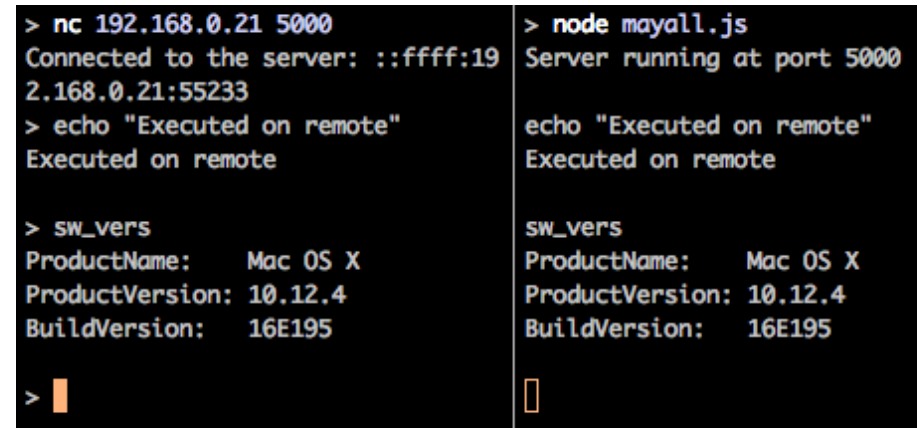
Figure 3. Remote Command and Control example through Netcat.